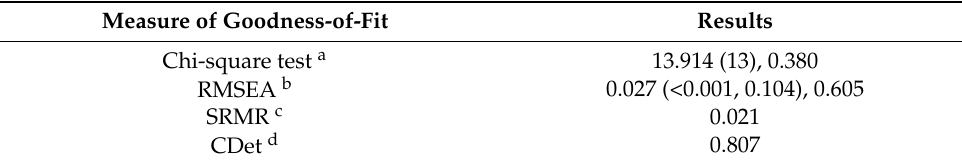
Table 3. Measures of goodness-of-fit of the final model presented in Table 2 and Figure 1.